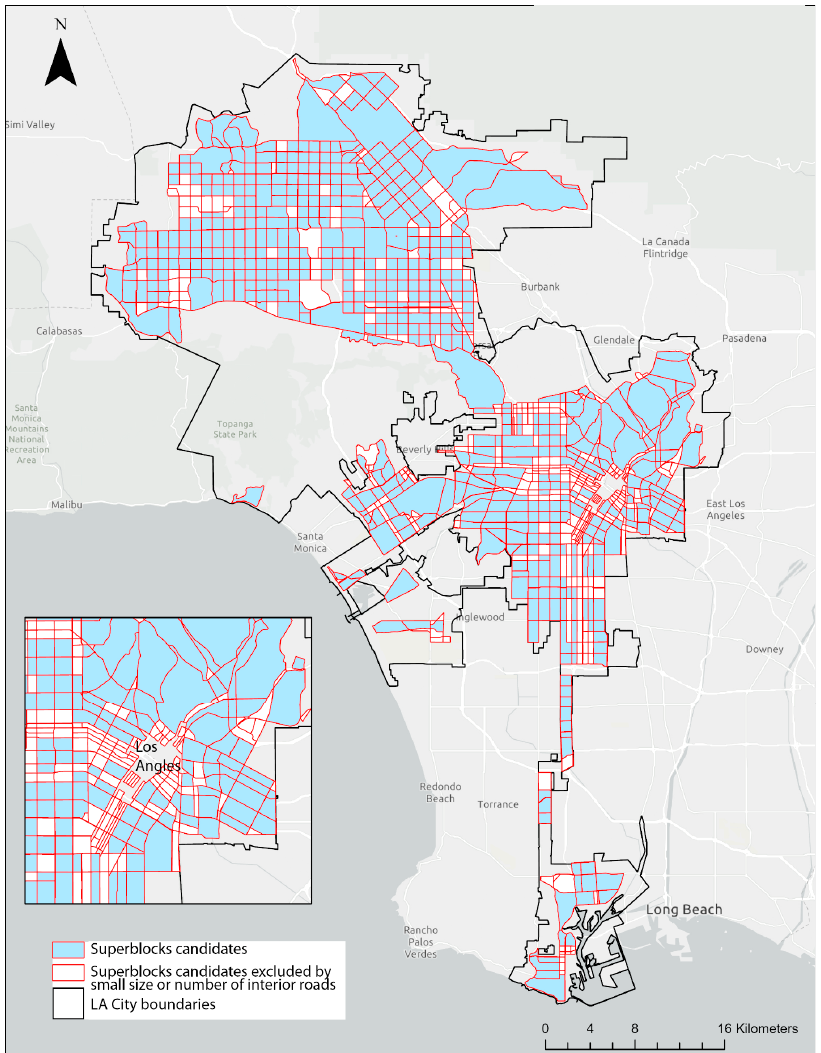
Figure 1. Superblocks generated by Rules I–V (blue) and Superblock candidates generated by Rules I–IV but excluded by Rule V (white).